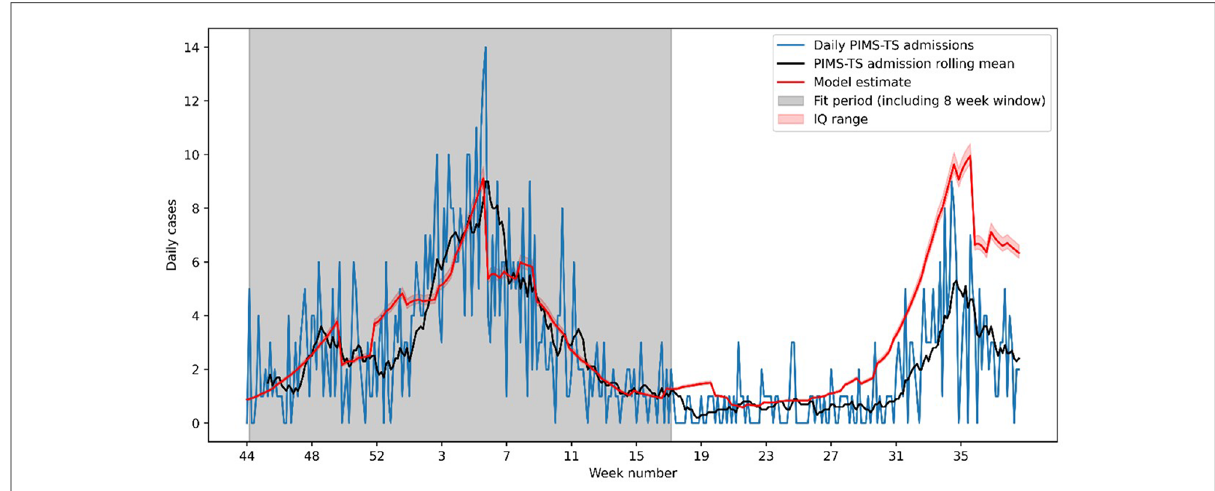
FIGURE 1 Observed and modelled PIMS-TS cases between week 44 of 2020 and week 40 of 2021. The model has been fi tted to data over the Alpha wave (week 44 of 2020 to week 17 of 2021). The resulting model signi fi cantly underestimates the number of PIMS-TS cases in the Delta wave (week 27